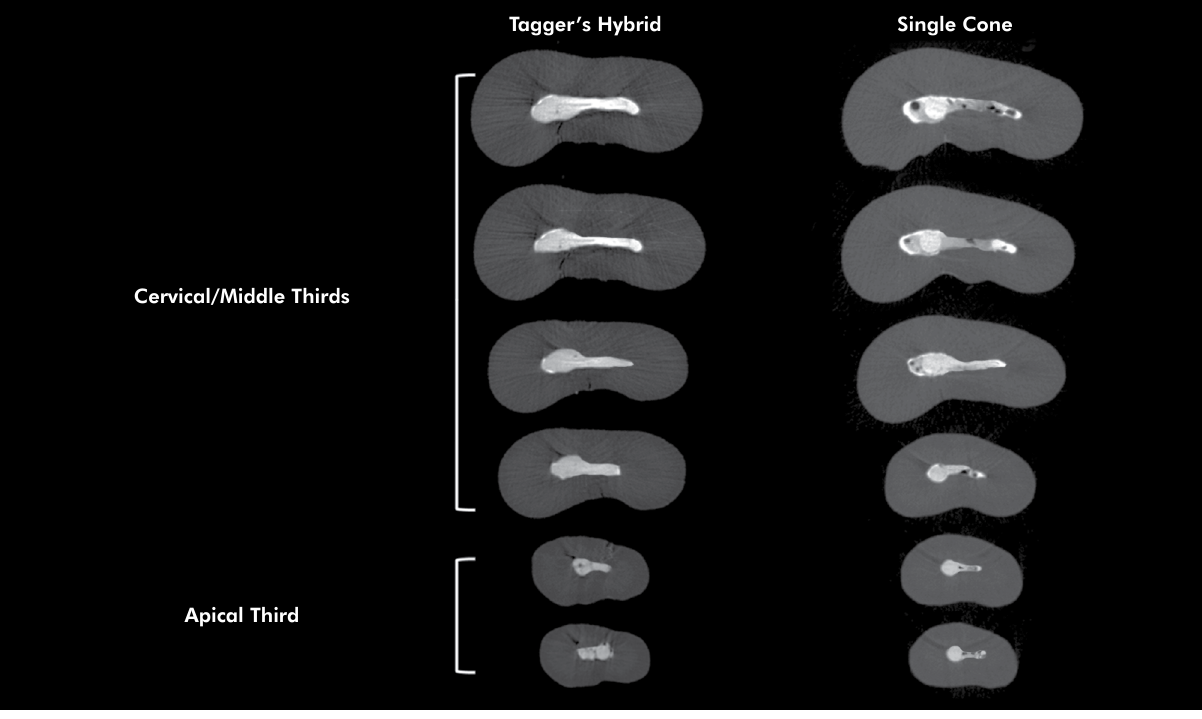
Figure 3. Cross-sectional images of two flattened distal canals of mandibular molars filled with Bio-C Sealer using thermoplastic or single-cone techniques. Filling material (white), voids